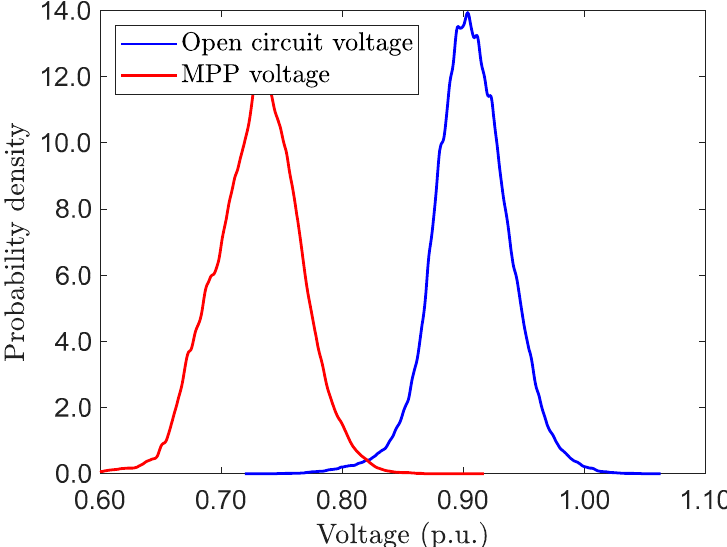
Figure 11. Probability density distributions of the MPP and open circuit voltages of the PV generator during the observation period.